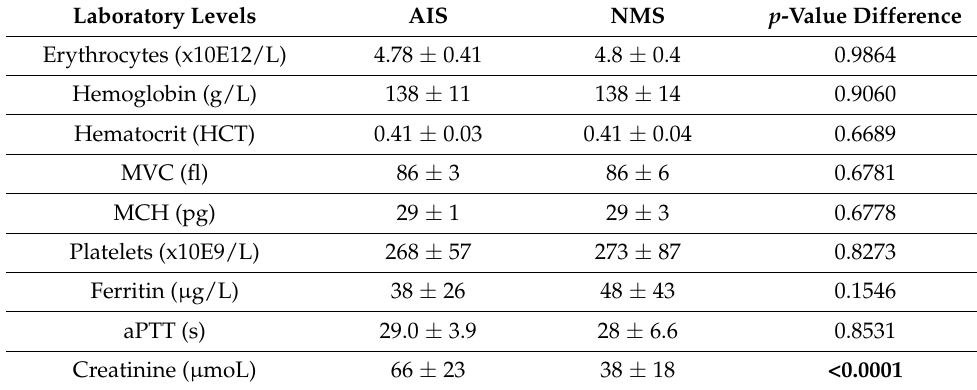
Table 2. Preoperative laboratory